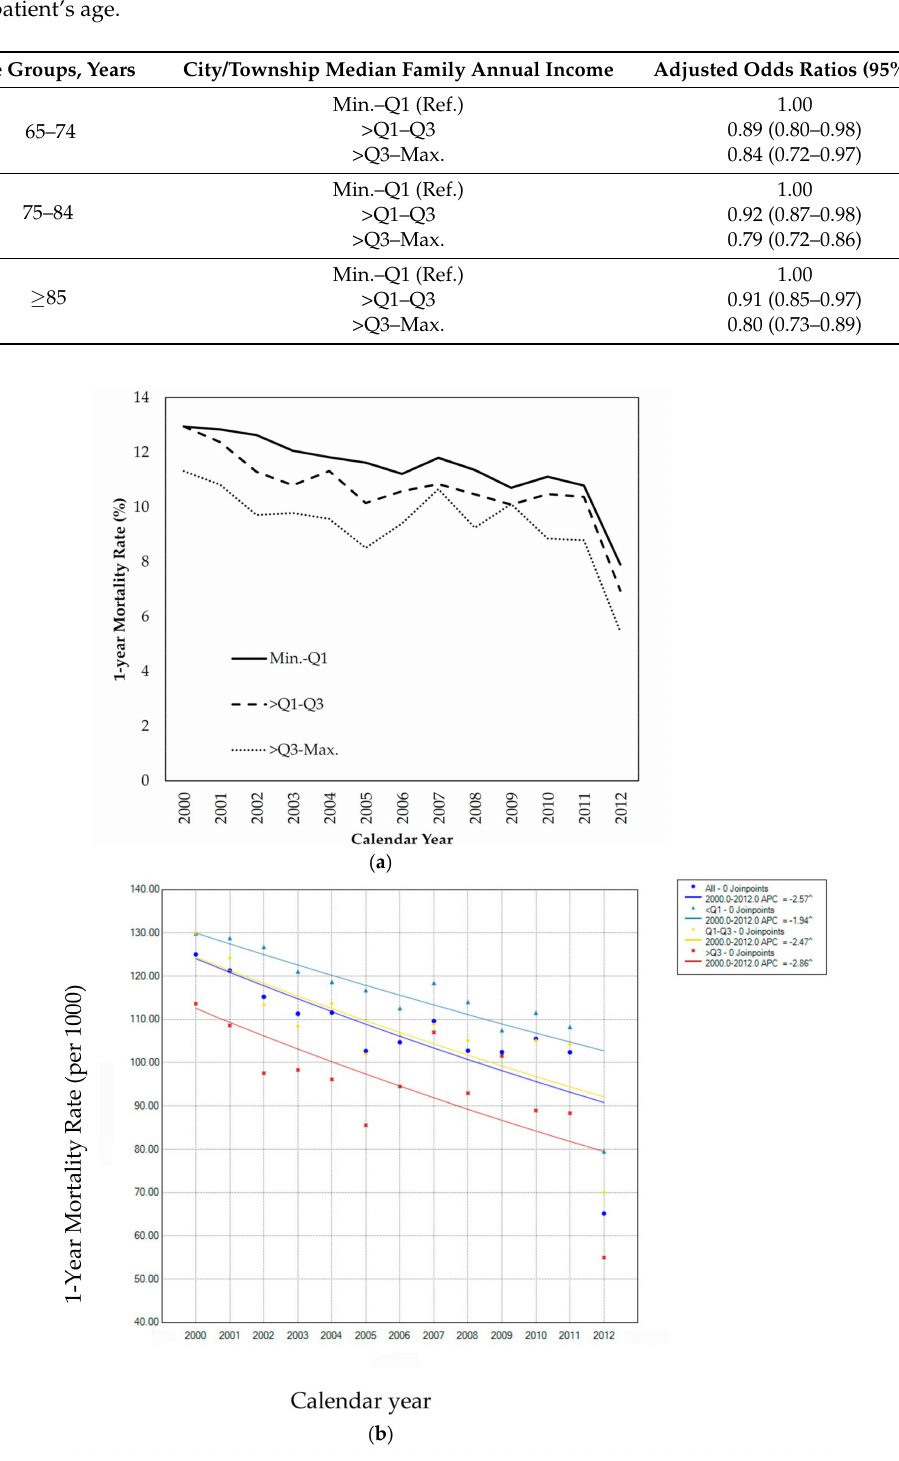
Figure 1. ( a ) Secular trend in socioeconomic disparity of one-year mortality rate from 2000 to 2012. ( b ) Jointpoint regression models estimating the annual percent change across the study